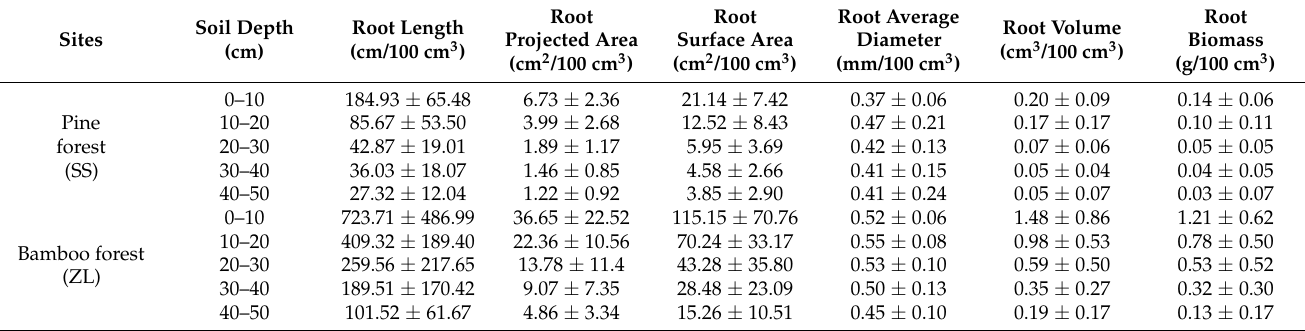
Table 3. The parameters of the root system architecture of the two